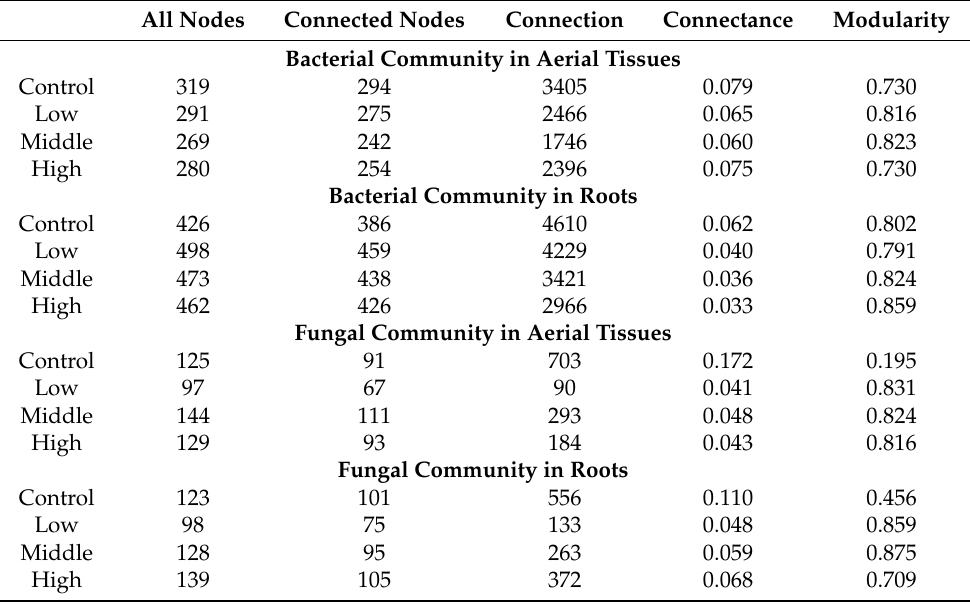
Table 2. Network characteristics of bacterial and fungal co-occurrence networks in aerial tissues and